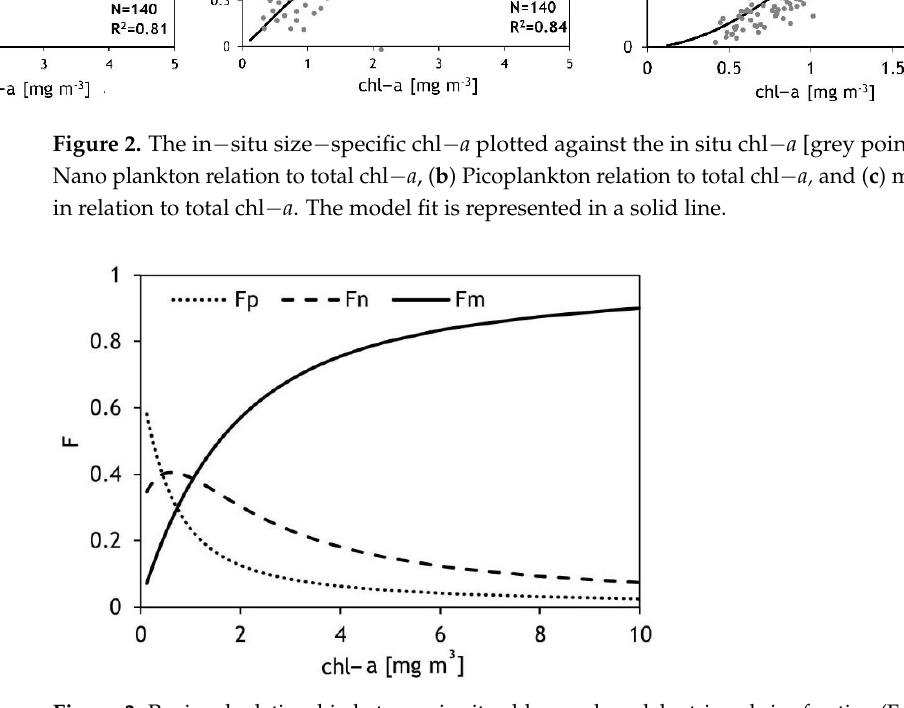
Figure 3. Regional relationship between in situ chl − a and model retrieved size fraction (F m , F n, and F p ). Table 2. Statistical results of the validation.